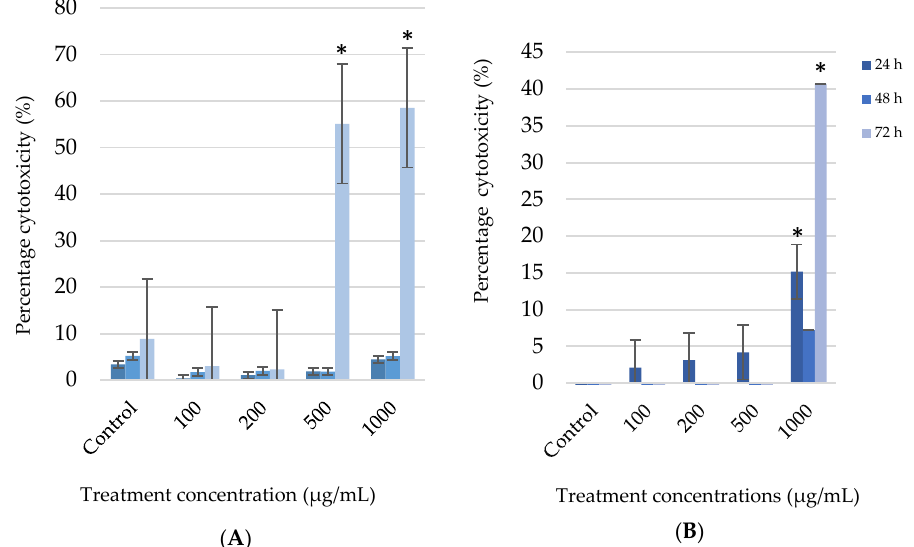
Figure 3. After the human melanoma (A375) cells ( A ) and normal human skin (HaCaT) cells ( B ) were treated with 100; 200; 500 and 1000 µg/mL concentrations of G. africana ethanolic extract for 24, 48 and 72 h, the cell cytotoxicity was determined using lactate dehydrogenase (LDH) assay. Data represent the mean ± SD, n = 3, where the * indicates statistical significance at level p < 0.05 vs. the